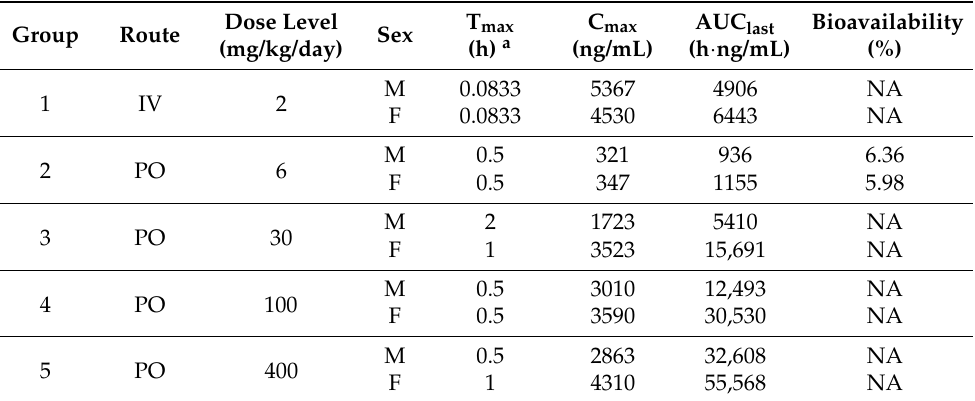
Table 1. Summary of mean ZB716 PK parameters in rat